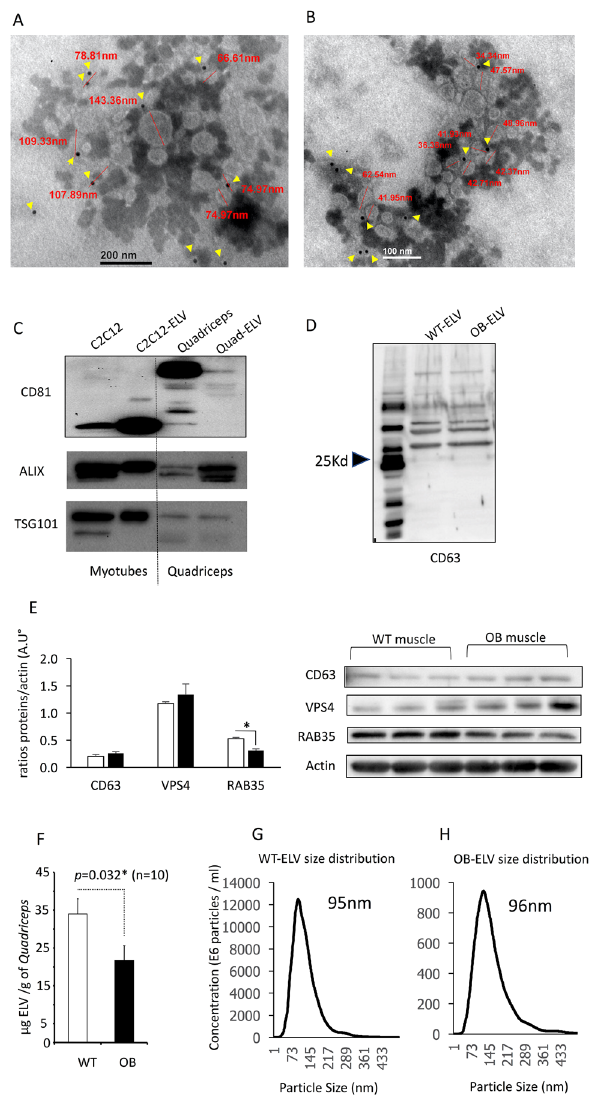
Figure 1. Characterization of SkM-derived exosome-like vesicles (ELVs). ( A , B ) Transmission electron microscopy showing WT-ELVs ( A ) and OB-ELVs ( B ) detected with anti-CD81 (yellow arrows = CD81-gold particles (15 nm), the sizes of labelled ELVs are indicated in red). ( C ) WB to identify SkM-ELVs specific proteins (CD81, TSG101, ALIX) in C2C12 and C2C12-released-ELVs, and in WT-Quad and WT-Quad-released ELVs. The same quantity of proteins was loaded. ( D ) WB to show that OB-ELVs and WT-ELVs expressed the exosomal marker CD63. ( E ) WB showing the levels of proteins involved in SkM-ELV release, in WT-Quad vs OB-Quad. ( F ) Quantification of ELVs released from WT-Quad or OB-Quad estimated from their quantity of proteins (Bradford assay). ( G , H ) SkM-ELVs size distribution quantified by Nano-tracking analyses. (* = p < 0.05 (student t-test)). WB originals are in Fig.